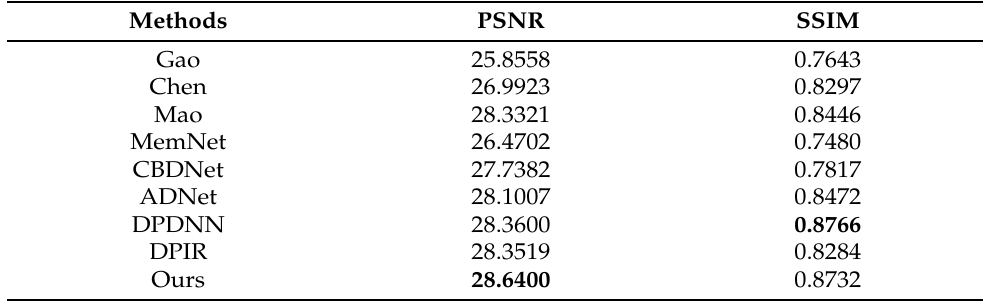
Figure 12. Restoration using different state-of-the-art methods on moderate turbulence blur (The red boxes represent the focus region). Table 4. Average PSNR and SSIM of different state-of-the-art methods on moderate degradation (The best results are shown in bold